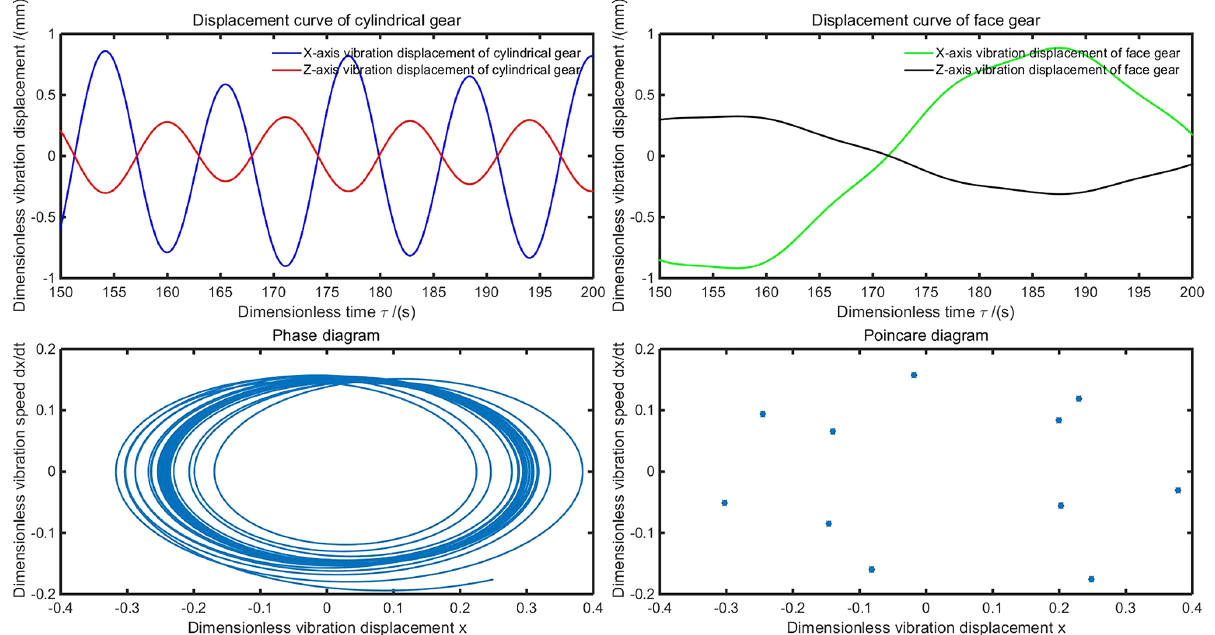
Figure 22. Displacement, phase, and Poincare diagrams of nonlinear system with excitation frequency 0.5495.